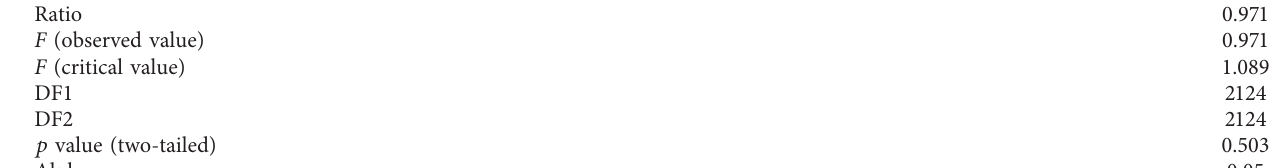
Table 3: Statistical results comparing CTM with I80.